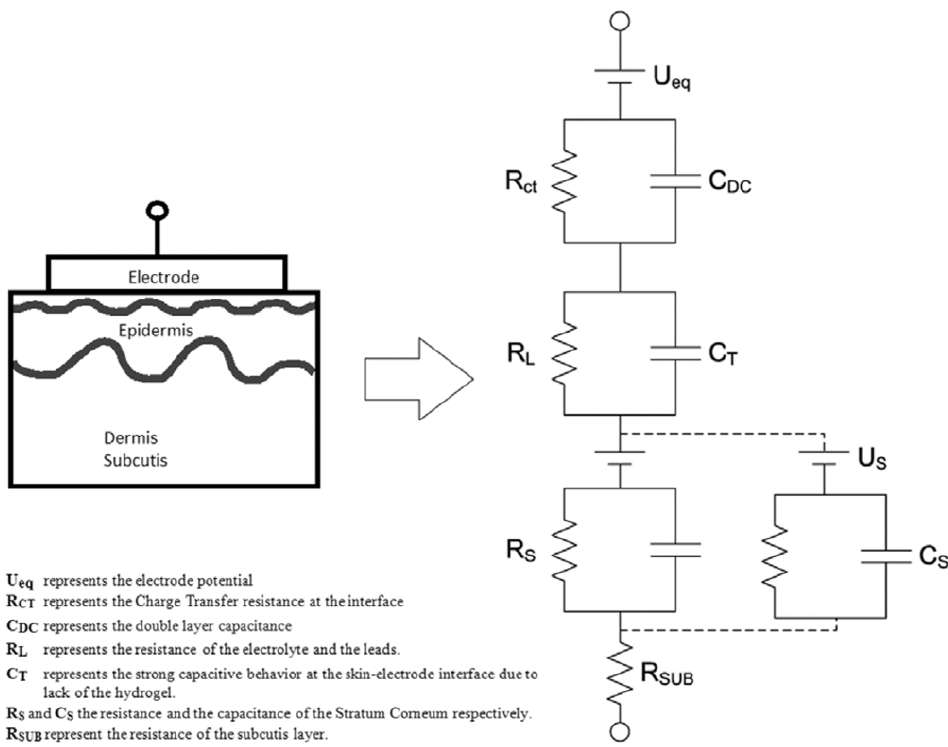
Figure 5. Equivalent circuit model for the skin–electrode interface. From Reference [83], originally published under a CC-BY license.